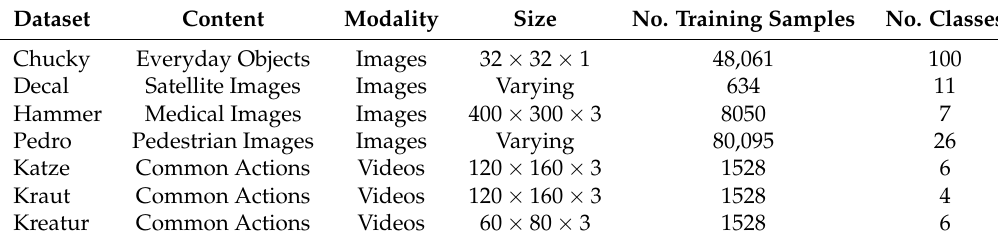
Table 1. Vision: Summary of vision